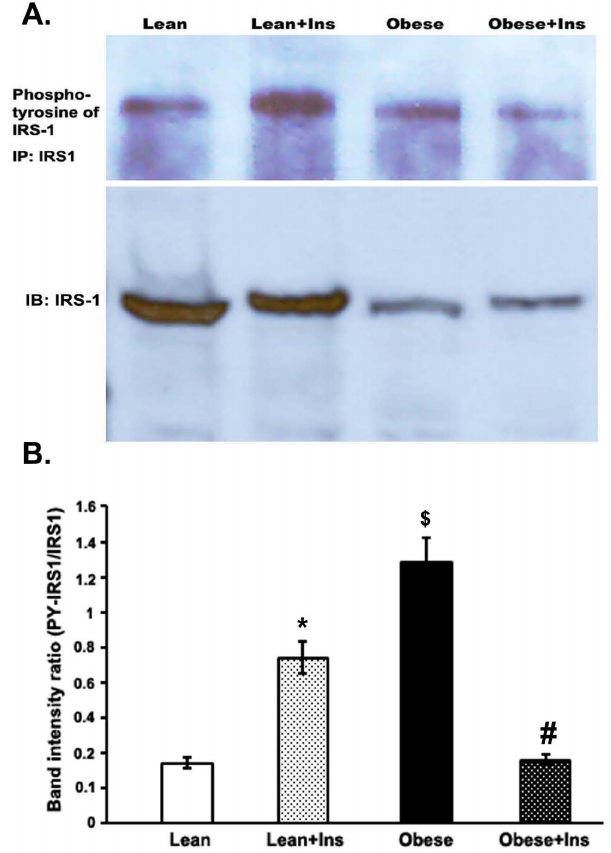
Figure 4. Tyrosine phosphorylation of IRS-1 in the gastrocnemius muscle of Zucker rats. Rats were anesthetized, and 5 units of insulin were intraperitoneally injected into both lean and obese rats. Then, 5 min later, gastrocnemius skeletal muscle was excised and homogenized in an extraction buffer at 4 ◦ C, as described in the Methods section. After centrifugation, aliquots with the same amount of protein were immunoprecipitated with anti-IRS-1 antibodies at 4 ◦ C and, subsequently, protein A-sepharose. ( A ). Immunoprecipitated proteins were immunoblotted with anti-pY-IRS-1 antibody. ( B ). Bands were quantitated with a Bio-Rad Molecular Imager and plotted as band intensity ratios of pY-IRS-1 to IRS-1. * p < 0.01; $ p < 0.01 vs. corresponding lean value; # p <0.05 vs. lean + insulin. In each group, at least four rats were